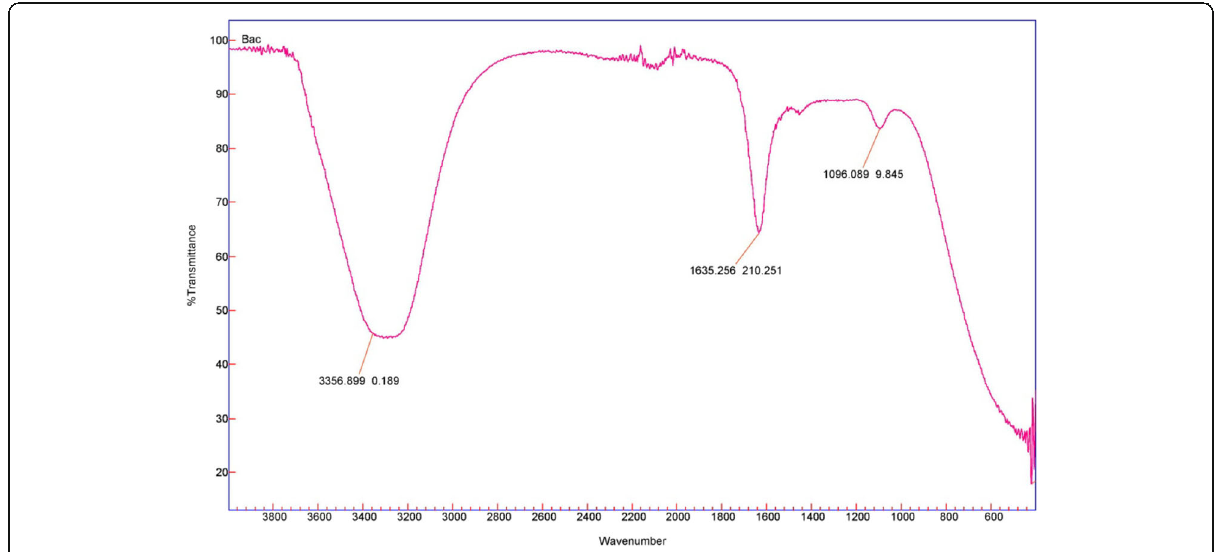
Fig. 5 FT-IR spectral analysis of purified bacteriocin from Enterococcus casseliflavus MI001